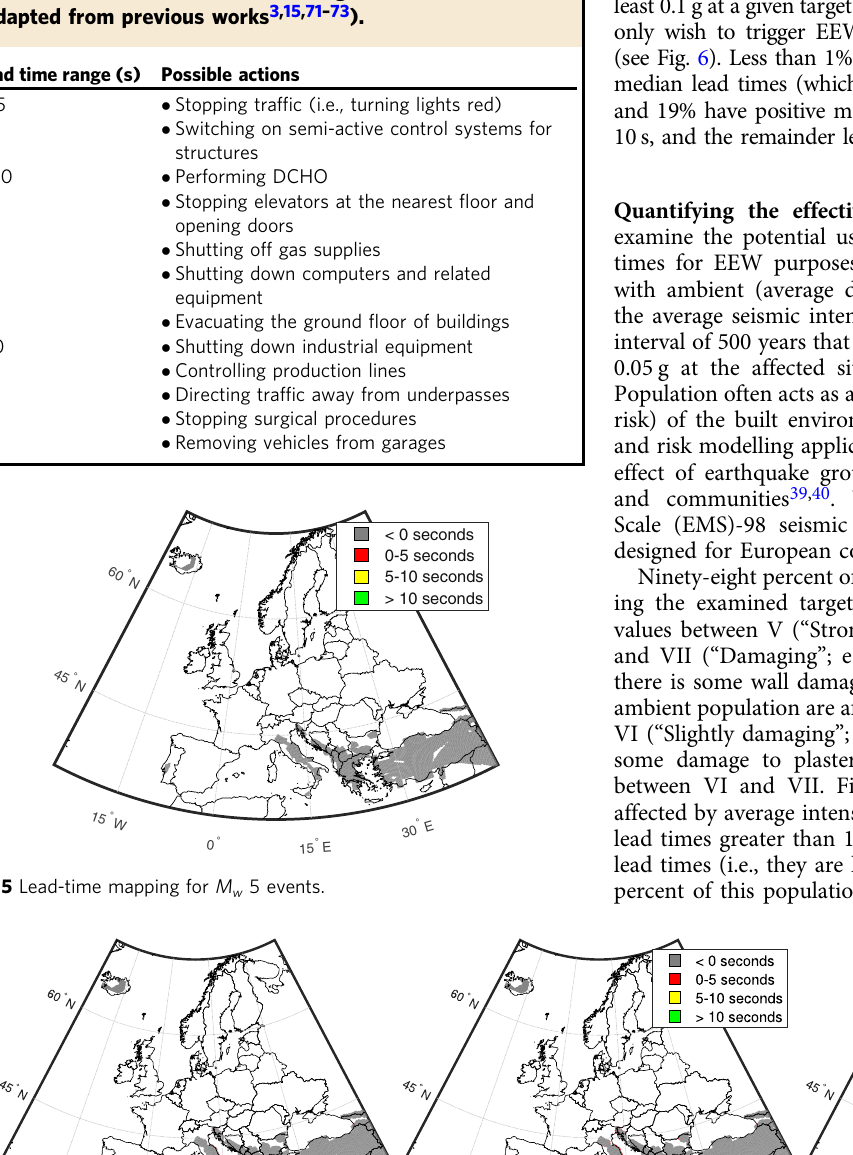
Table 1 Possible risk-mitigation actions that can be taken by various stakeholders for different lengths of EEW lead time (adapted from previous works 3,15,71 – 73 ).